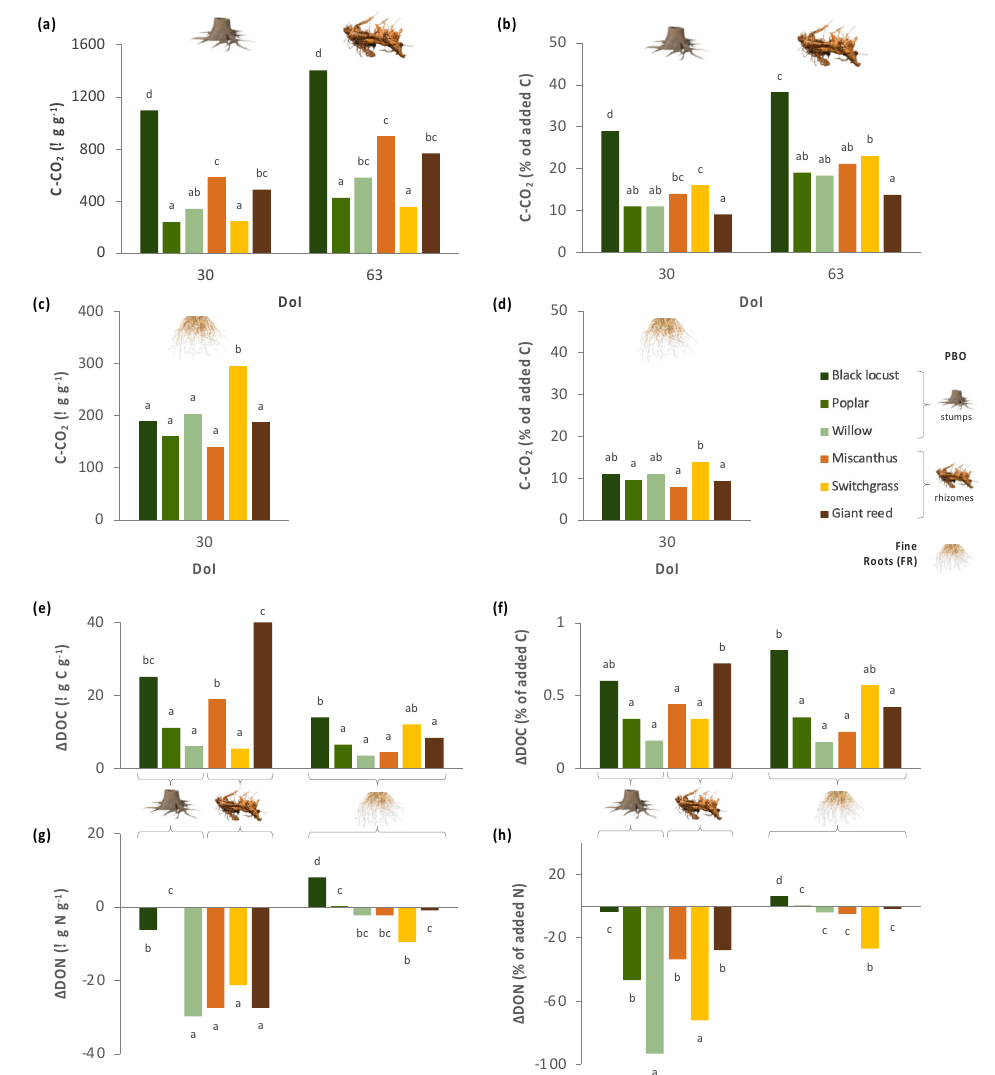
Figure 3. Absolute ( µ g C-CO 2 g − 1 ) and relative (% of added C) mean values of carbon respired as CO 2 ( a – d ) for PBO ( a , b ) and fine roots ( c , d ) at 30 and 60 days of incubation (DoI); absolute ( µ g g − 1 ) and relative (% of added C,N) mean values of the difference at the end of incubation of dissolved organic carbon (DOC) ( e , f ) and nitrogen (DON) ( g , h ) in soil from EOM mineralization with respect to control. Different lowercase letters show statistically different means among PBCs (Tukey’s test, p : 0.05) for each parameter within the same EOM type.